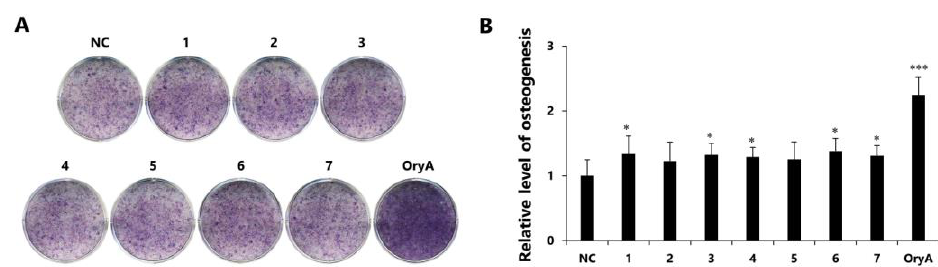
Figure 6. The effects of compounds 1–7 on the differentiation of mesenchymal stem cells (MSCs) toward osteoblasts. ( A ) Stimulatory effect of compounds 1–7 on osteogenic differentiation of MSC. Fully-differentiated C3H10T1/2 cells were stained with alkaline phosphatase (ALP) at 9 d after osteogenic differentiation with 20 µM of compounds 1–7 . ( B ) ALP enzyme activity was measured in osteogenically differentiated C3H10T1/2 cells treated with compounds 1–7 . The values were calculated relatively by setting the untreated negative control to 1. Oryzativol A (5 μM) was added to the experimental set as a positive control and marked as OryA. * denotes p < 0.05 and *** denotes p < 0.001.